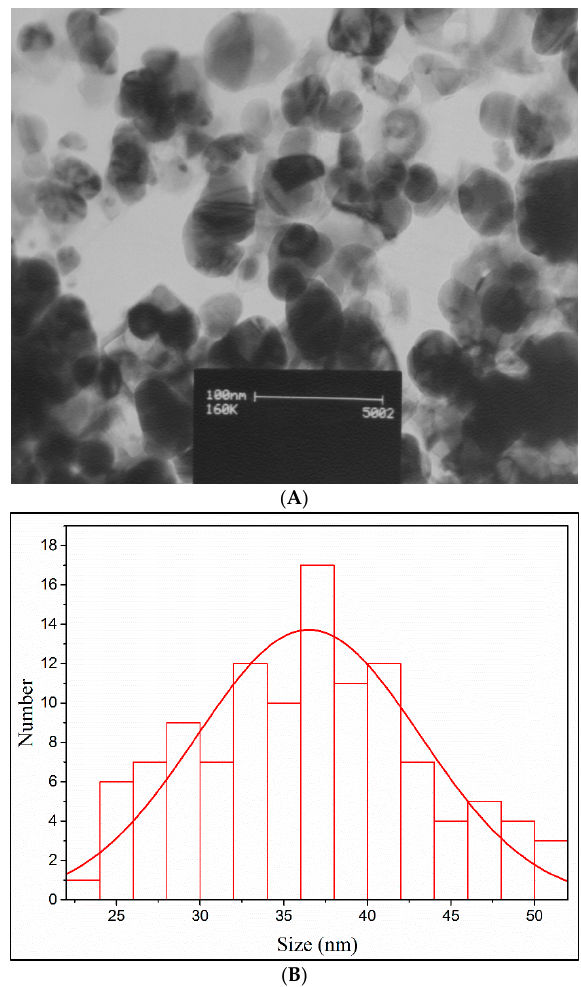
Figure 3. ( A ) The TEM image, and ( B ) the particles size distribution of the AgNPs phytofabricated by using the O. persica leaf extract.